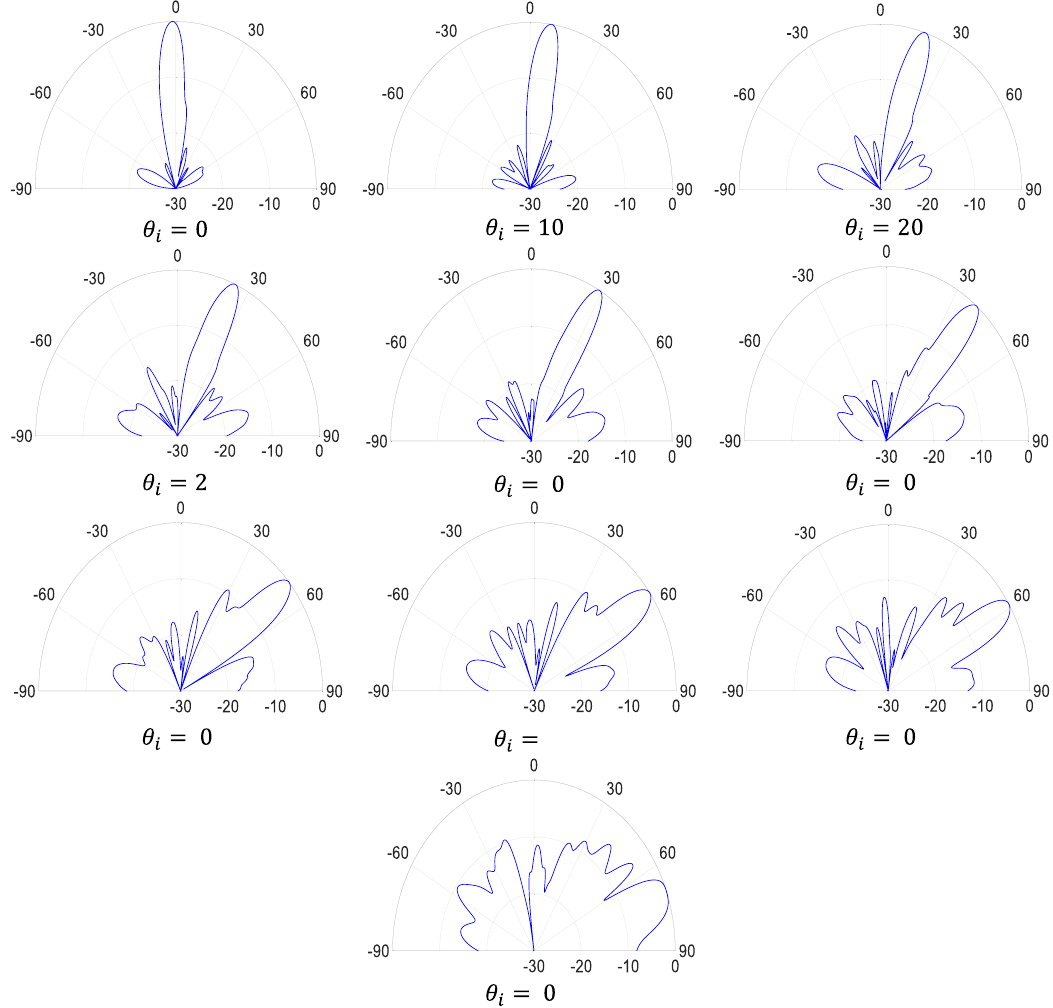
Figure 6. The normalized intensity of the scattered field (dB) for the cloaked bump under Gaussian wave incidence with incident angles in the range of 0 to 70 degrees.